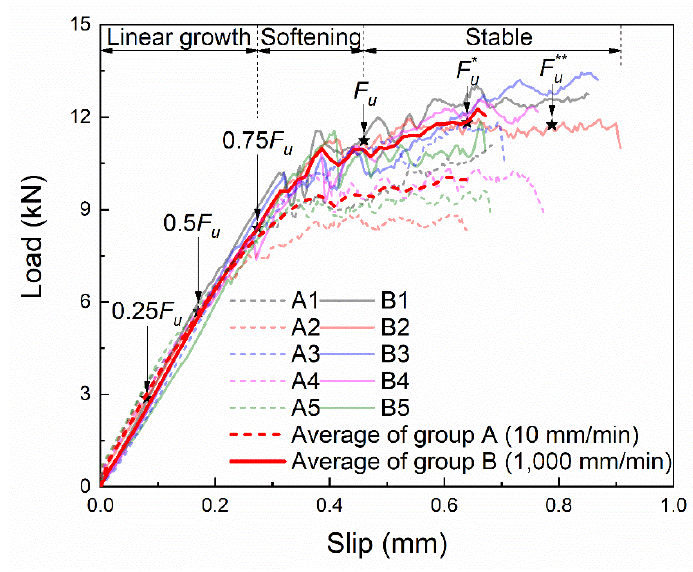
Figure 5. Load–slip curves of the tests.